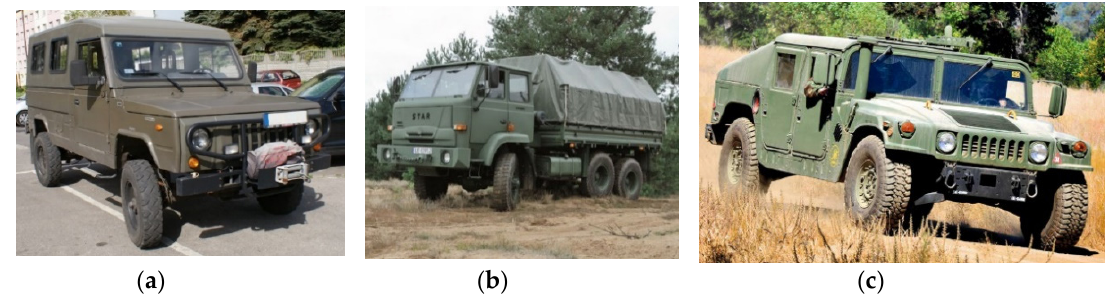
Figure 4. Analyzed vehicles: ( a ) Honker [54]; ( b ) Star 266 [55]; and ( c ) HMMWV (High Mobility Multipurpose Wheeled Vehicle; colloquially: Humvee) [56].